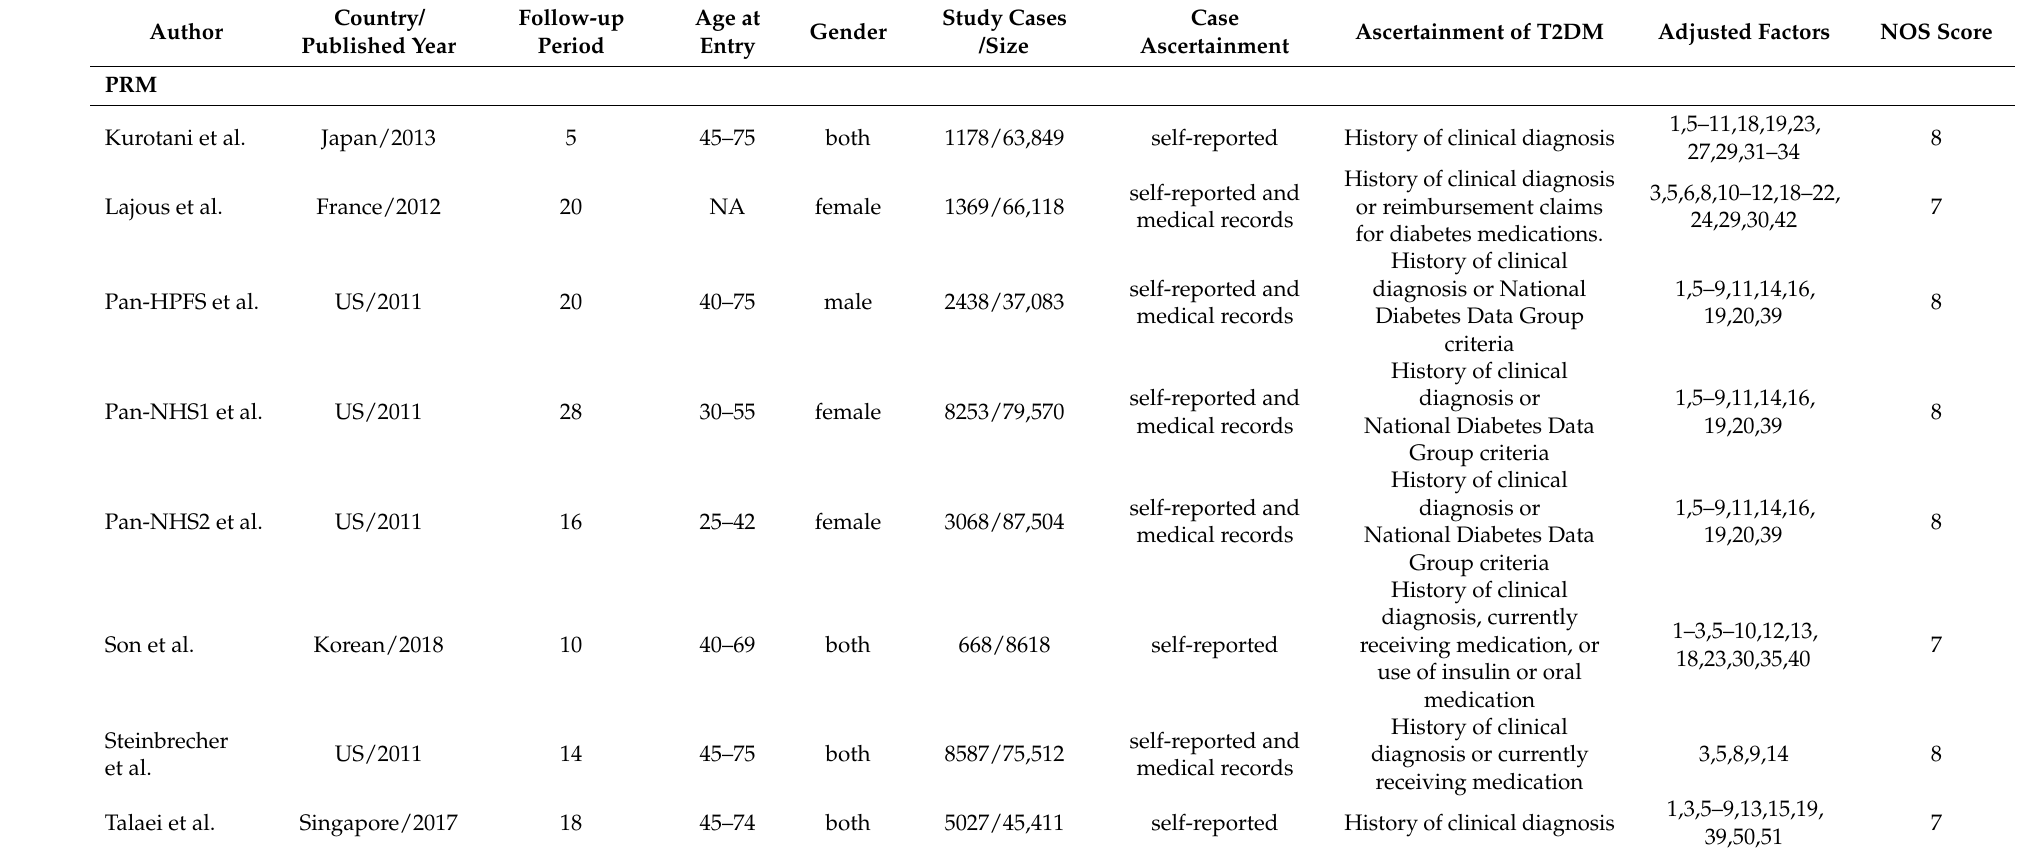
Table A1. Characteristics of included